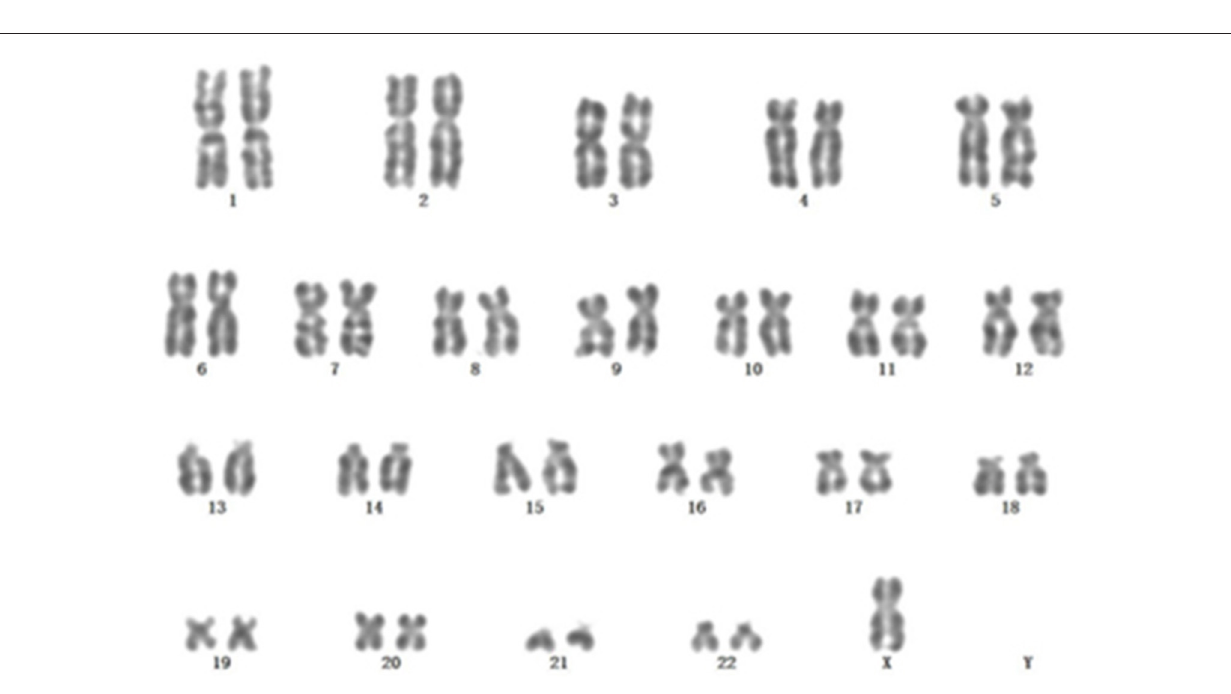
FIGURE 4 | Karyotype analysis: 45, X, Y [20]. All the cells analyzed had Y chromosome